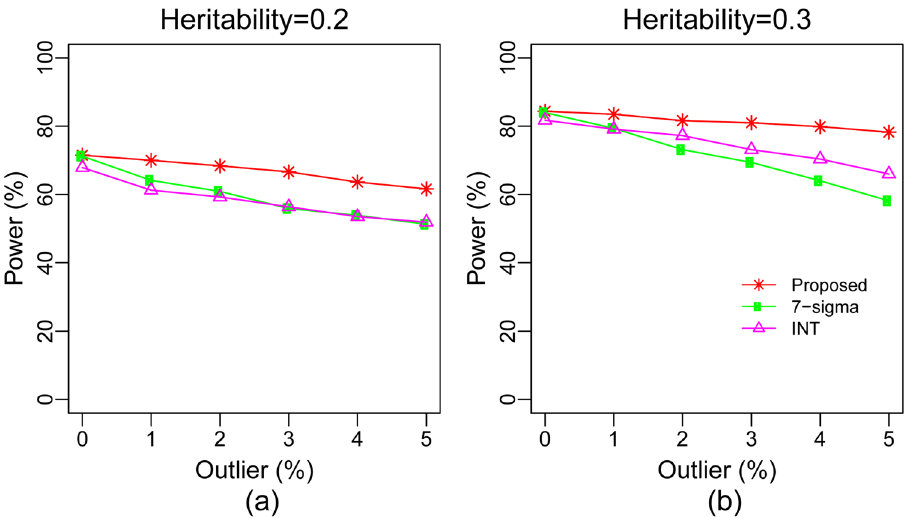
Figure 2. Plot of statistical power against the rate of phenotypic outliers based on the same dataset as used in Fig. 1 computed by three methods 7-sigmarule, inverse normal transformation (INT) and the proposed methods.